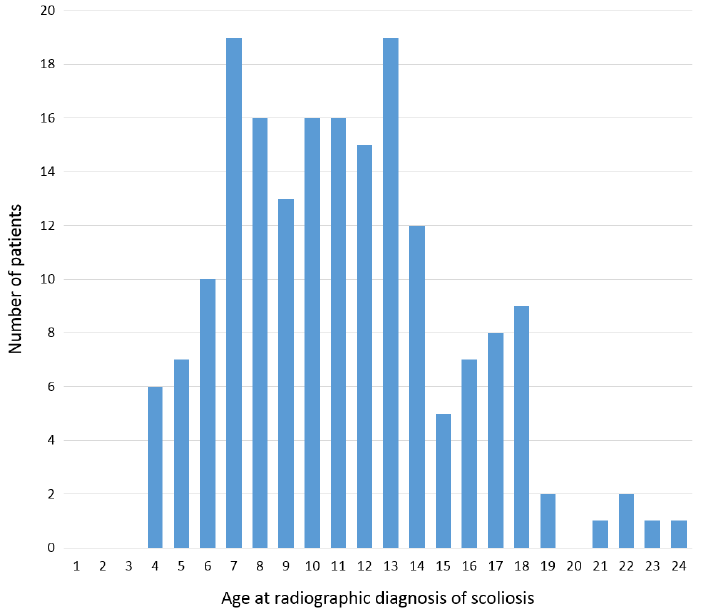
Figure 3. The age distribution at the moment of initial radiographic diagnosis of scoliosis. In the 185 included 22q11.2 deletion syndrome patients in this study, the mean age at diagnosis was 11.6 ±